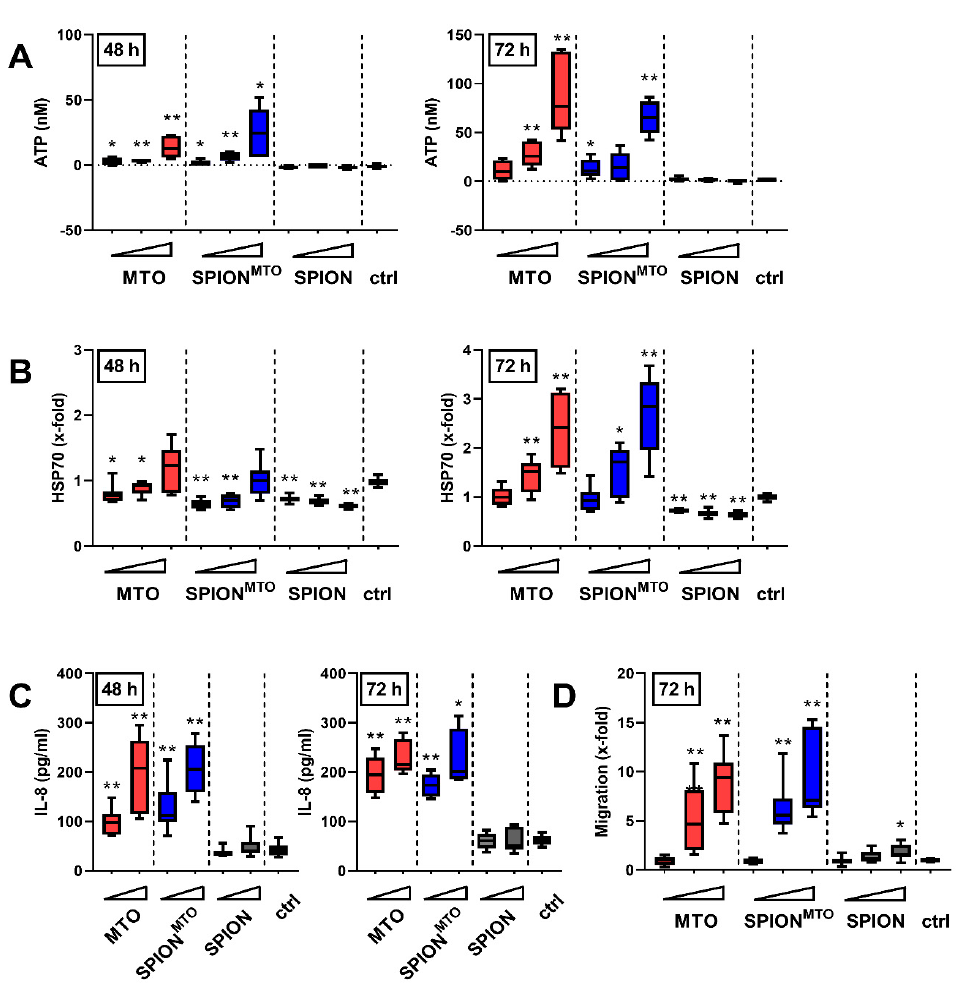
Figure 4. Release of damage-associated molecular patterns (DAMPs) from dying cells. The supernatants of cells which had been treated with SPION, MTO or SPION MTO for 48 h or 72 h were analyzed via ATP-mediated chemiluminescence ( A ), HSP70 ELISA ( B ) or IL-8 bead-based immunoassay ( C ). ( A,B,D ) 0.5, 1.0 or 2.0 µ M MTO and corresponding iron amounts were used according to Table 2 (see triangle); (C) 1.0 and 2.0 µ M MTO were applied. ( D ) Supernatants were used as chemoattractant for THP-1 monocytes. Data represent number of THPs migrating towards the supernatant. The supernatant from H 2 O-treated cells served as control. Shown are the mean values and standard deviations of three independent ( A,B,D ) or two independent triplicates ( C ), respectively. Significances were calculated using Student’s t -test comparing treatment versus control group and MTO-treated cells versus SPION MTO -treated cells (* p < 0.05; ** p < 0.01).